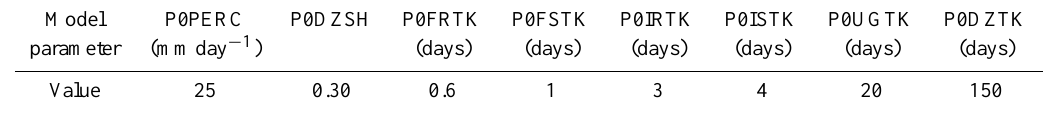
Table 2. Averaged values for the parameters of UBC watershed model affecting the time distribution of runoff (Micovic and Quick, 1999).